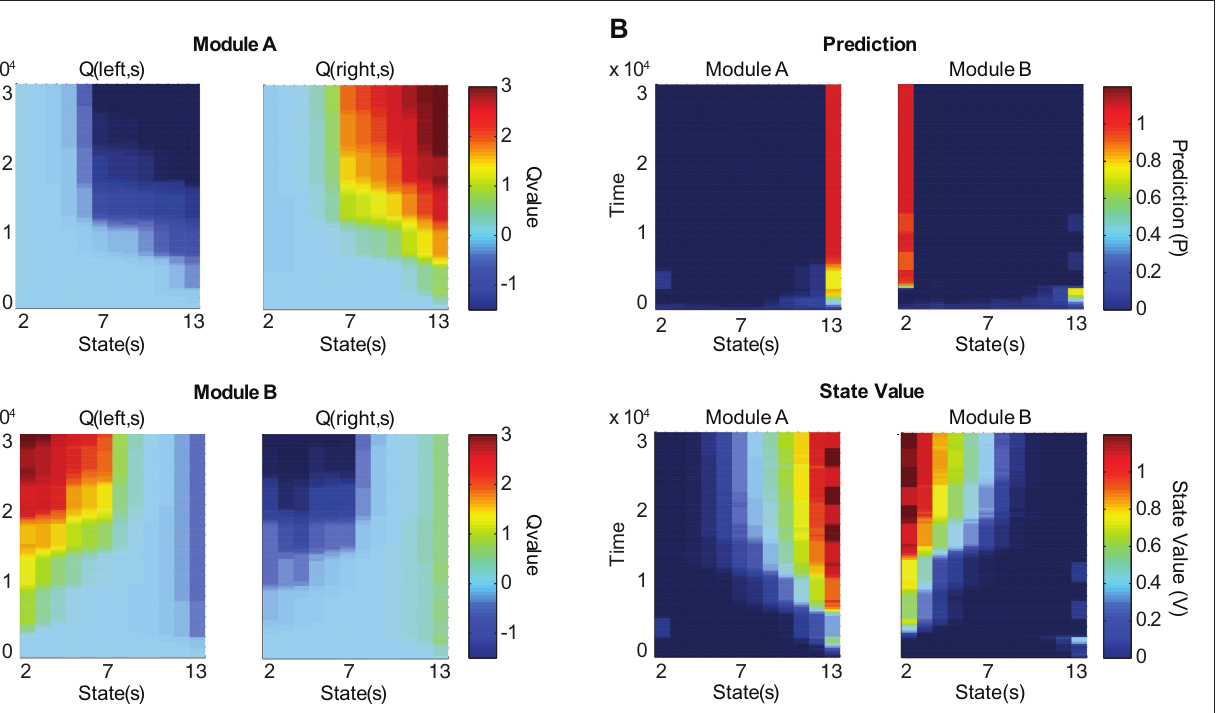
module A selectively prefers rightward movements and module B selectively prefers leftward movements. (B) Prediction and state value functions of each module. Top two panels represent the prediction ( P ) of each module. Bottom two panels represent the state value function ( V ) of each module. Left panels show the functions for module A and right panels show the functions for module B. After training, module A predicts that the reward is likely to be obtained in the rightmost position and assigns the rightmost position the highest state value, while module B makes these assignments for the